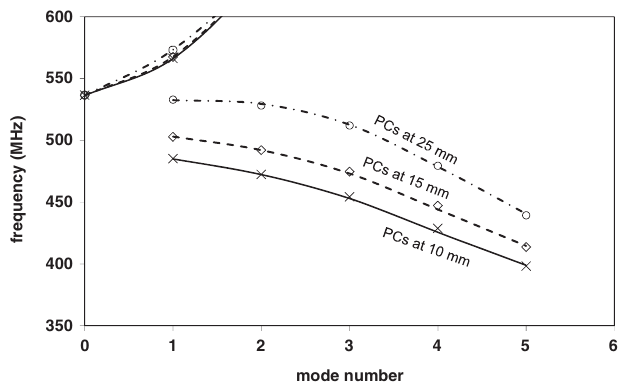
FIG. 23. Frequencies at 3 different values of the gap PC-DT. A larger gap corresponds to higher PC frequencies and to a larger frequency distance between TM